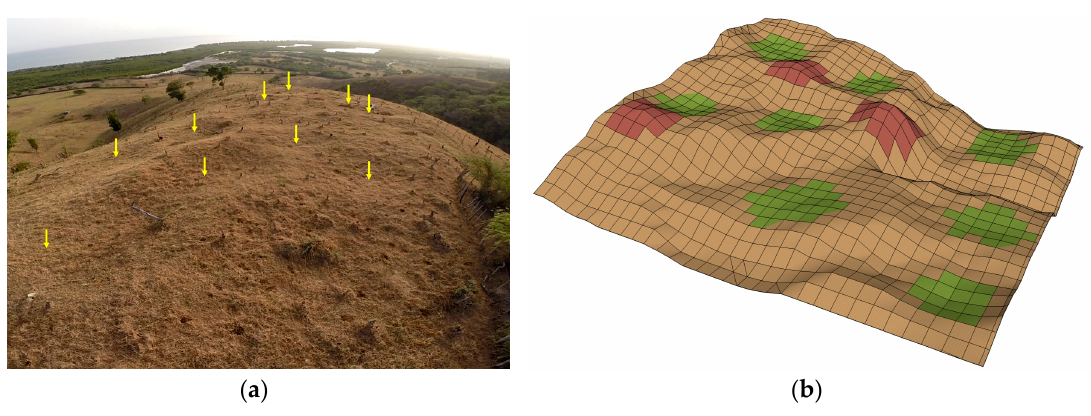
Figure 2. ( a ) A drone image showing the human impact on the topography of the Rafelito Rosa site with the flattened areas shaded by the morning sun, are marked by yellow arrows; ( b ) a 3D sketch highlights the type of topography that the survey focused on: green squares pointing out the concave form of the flattened areas, bounded by the mounds colored in dark red.